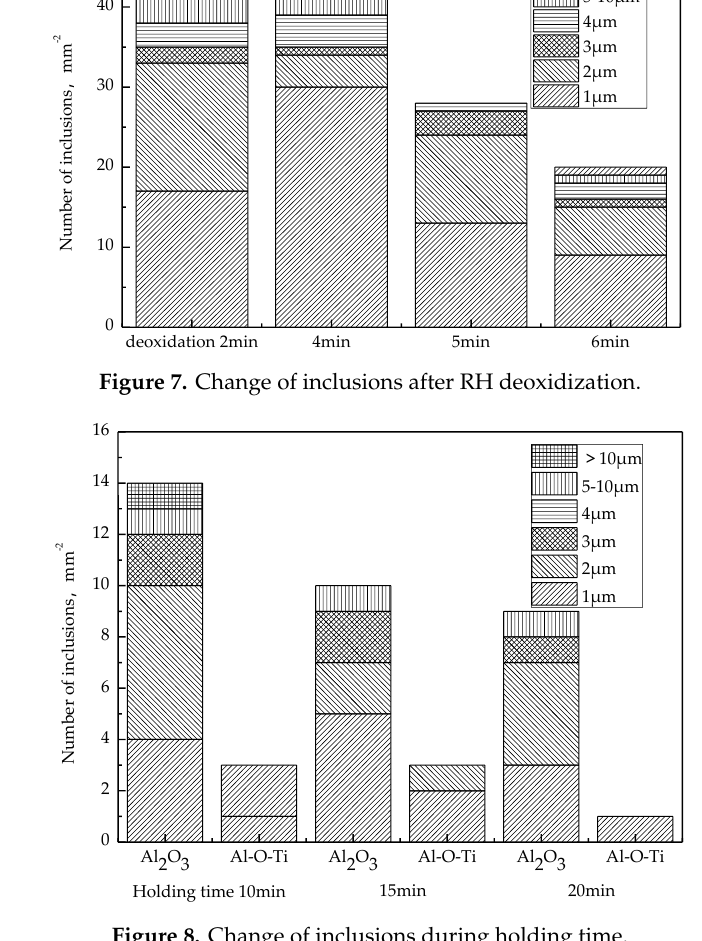
Figure 8. Change of inclusions during holding time.